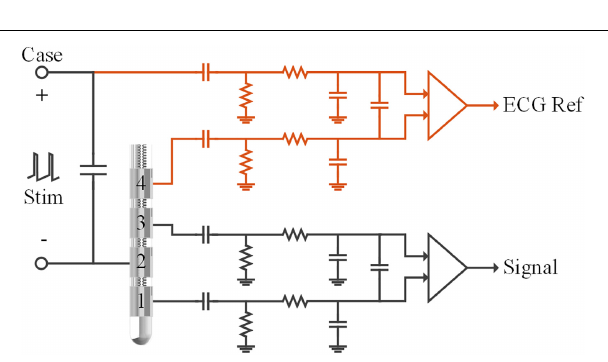
FIGURE 2 | Schematic of the recording module in the sensing-enabled neurostimulator. LFPs were recorded in the bipolar recording channel (between contacts 1 and 3). The ECG signals were recorded in the monopolar recording channel (between the titanium case and contact 4). The capacitors and resistors in each chain formed passive band-pass filters (0.3–250Hz) of the analog-front-end circuits. Monopolar stimulation was delivered between the titanium case and contact